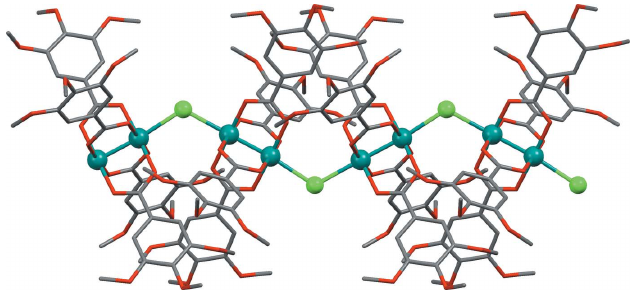
Figure 3 Crystal packing of zigzag chains of [Ru 2 Cl{ (cid:2) -O 2 CC 6 H 2 -3,4,5-(OMe) 3 } 4 ] n along b axis.